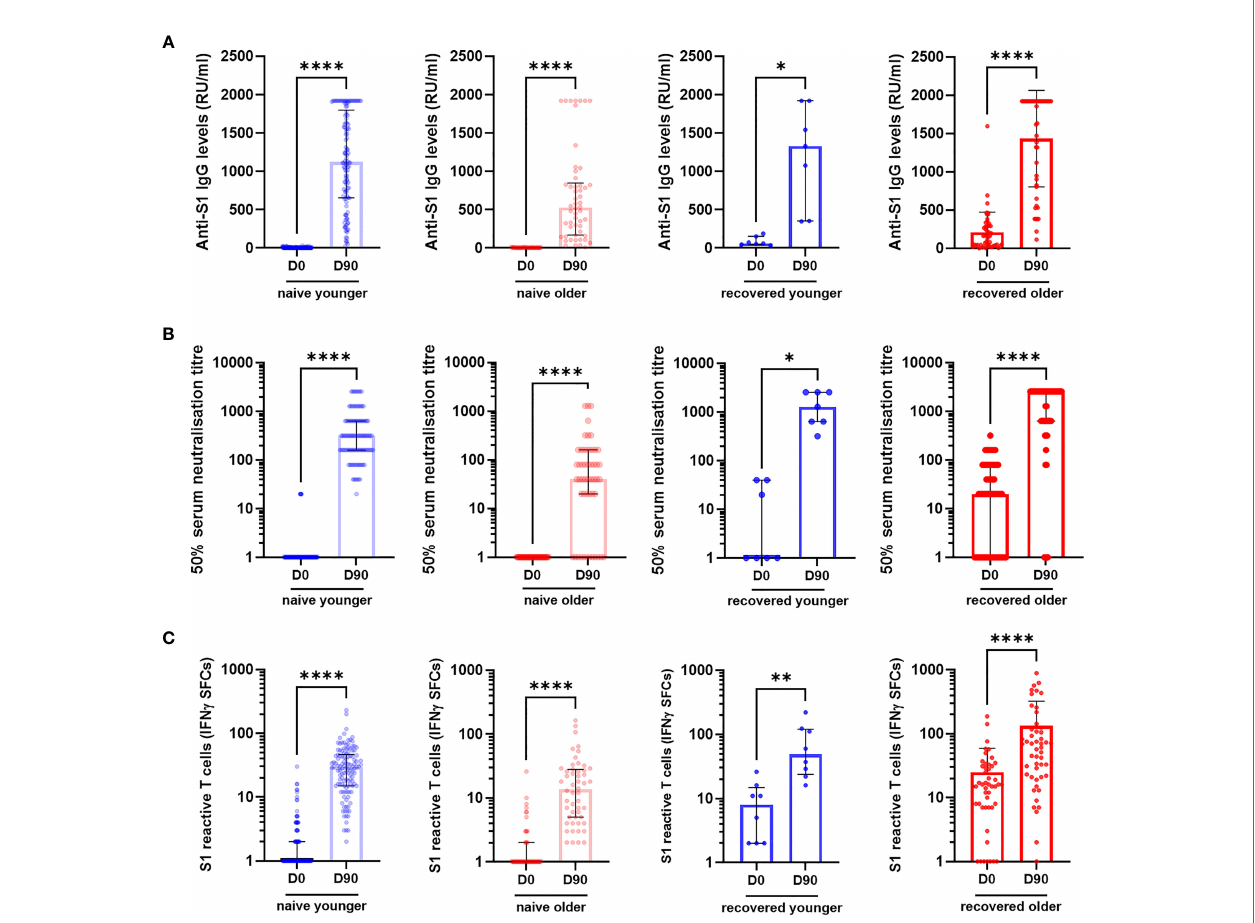
FIGURE 2 | Speci fi c antibody and T-cell responses in older and in young adults before (D0) and 3 months (D90) after the fi rst injection of BNT162b2. (A) Anti-S1 IgG, (B) serum neutralization assay against live virus, and (C) S1-reactive T cells (ELISpot) in COVID-19-naïve and in COVID-19-recovered participants. Wilcoxon matched-pairs signed rank test was used for paired comparisons. * p -values < 0.05; ** p -values < 0.01; **** p -values < 0.0001. CTL, IFN g SFCs, interferon gamma spot-forming